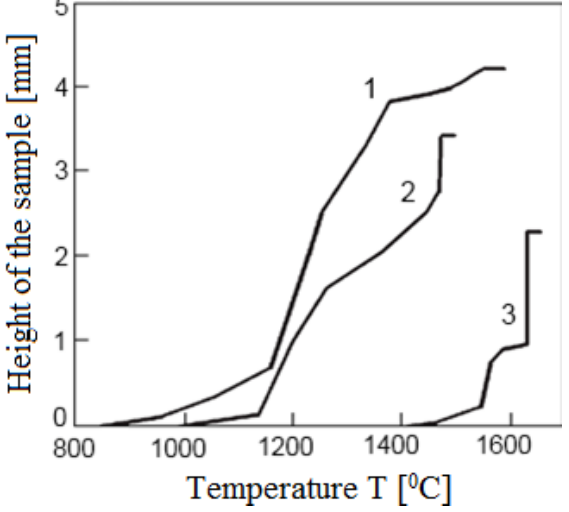
Figure 51. Microstructure of the TiN-35AlN layer in a 3-layer structure: ( a ) near the boundary with the B C-TiB layer; ( b ) in the center of the layer; and ( c ) near the surface of 4 2 the sample.